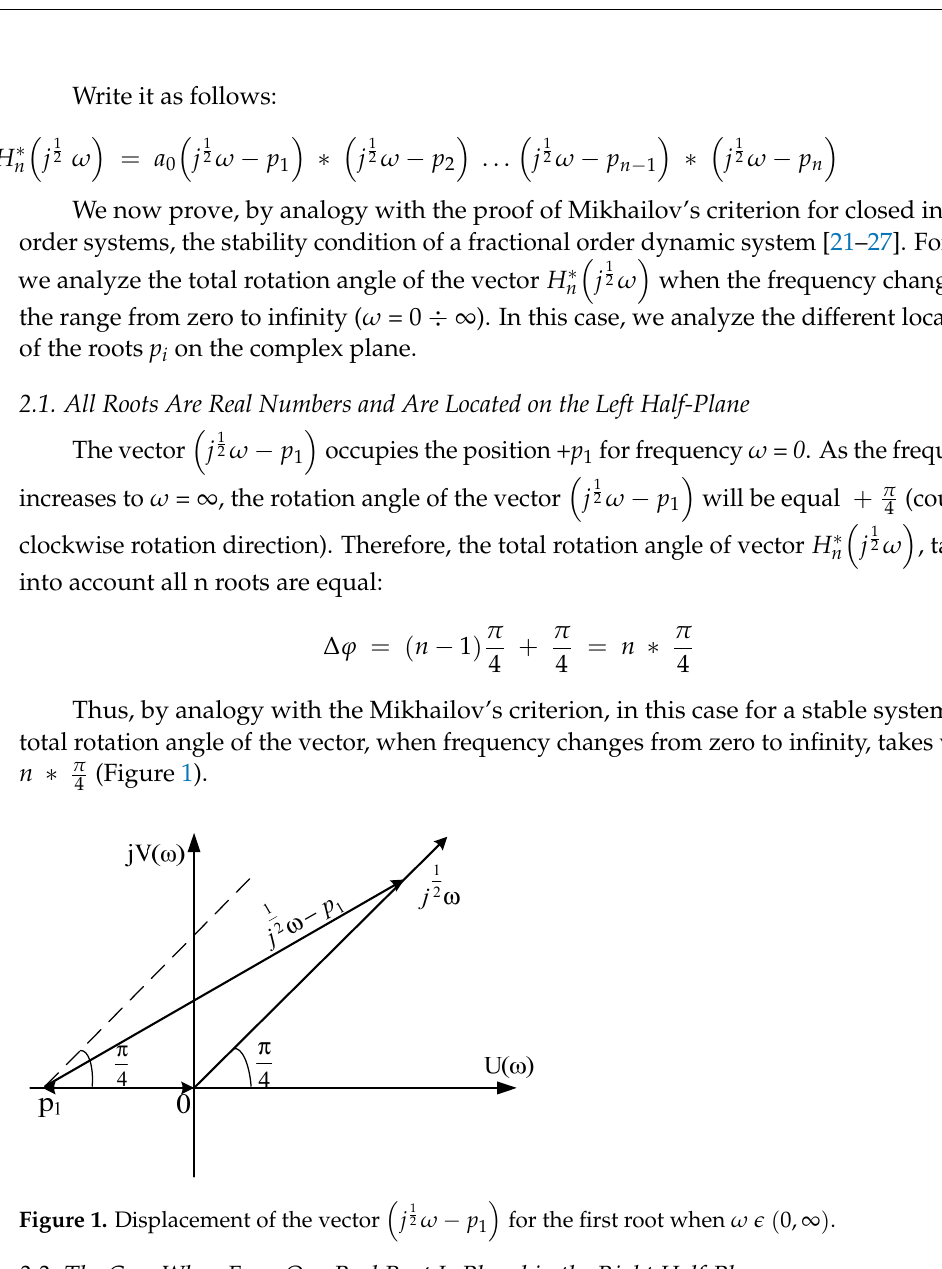
(cid:3117) (cid:3118) 𝜔 − 𝑝 (cid:2869) (cid:4673) for the first root when 𝜔 𝜖 (0, ∞) .